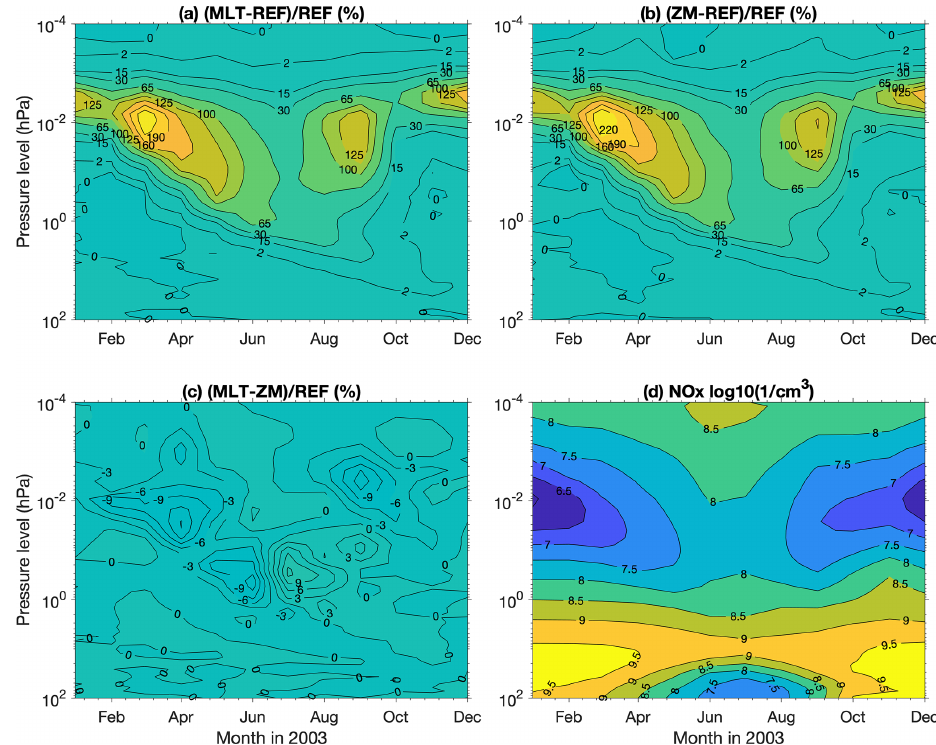
Figure 7. Southern Hemisphere (SH) polar-cap NO x , monthly means for year 2003. Panels (a) – (d) are as in Fig.